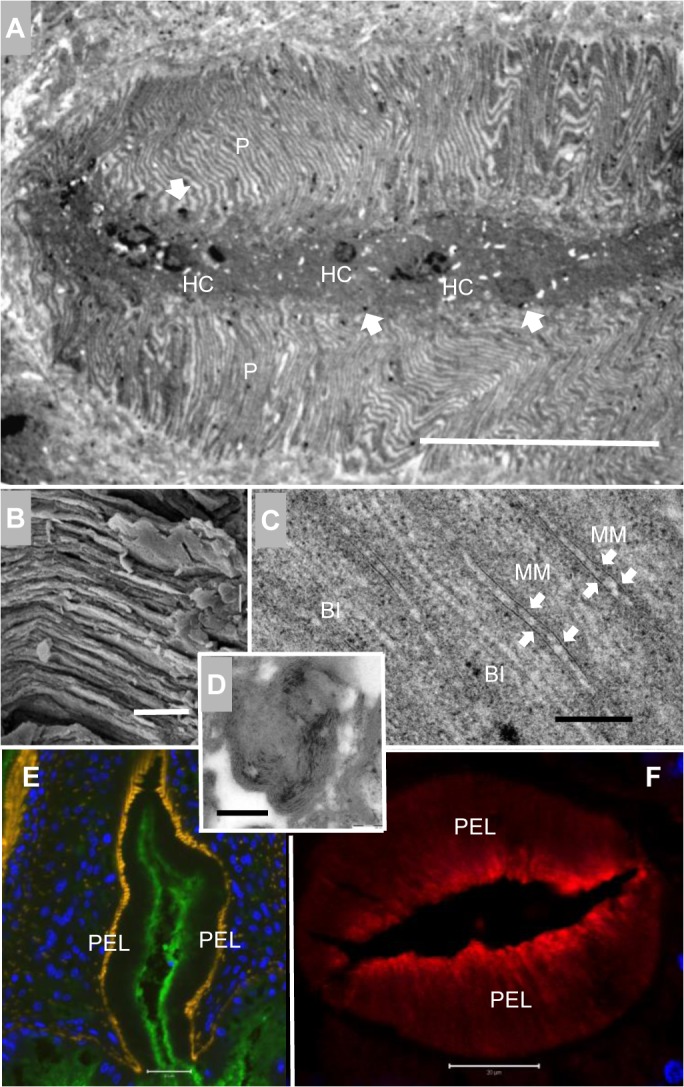
Host antibody binds to the posterior esophagus which shows an altered cellular morphology.(A) TEM image of the posterior esophagus, showing the luminal plates (P) tightly packed and closely adherent. The lumen appears congested, occluded by debris and host cells (HC) in the center; electron dense structures (arrowed) are also visible around the edges of the debris. (B) SEM image of the plates in the posterior esophagus, showing that intervening spaces are largely absent. (C) TEM image at high magnification reveals the parallel tramline appearance of posterior esophageal plates. Where two adjacent plates are particularly closely adherent, membranous material is visible (MM, arrowed) bound to the luminal surface. The two lighter lines in the center of each plate denote the basal invagination (BI). (D) High magnification image of electron dense structures revealing they are aggregates of membranous material. Confocal images of male worm heads: (E) a longitudinal section, stained with AF488 labeled anti-monkey IgG, and (F) a transverse section, stained with Cy3 labelled anti-monkey IgG. (E) is counterstained with DAPI (blue) and phalloidin (orange) to highlight the nuclei and musculature and (F) with DAPI only. Both images reveal that intrinsic antibody (green in E, red in F) has bound to the post esophageal lining (PEL). The luminal edges of lining plates are strongly positive whilst the surface of the plates is more weakly stained. Scale bars: 20 μm (A, E, F), 2 μm (B), 200 nm (C, D).